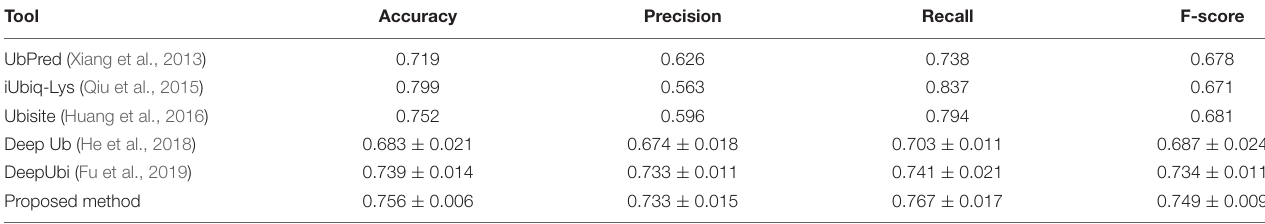
TABLE 4 | Performance comparison with other prediction tools.